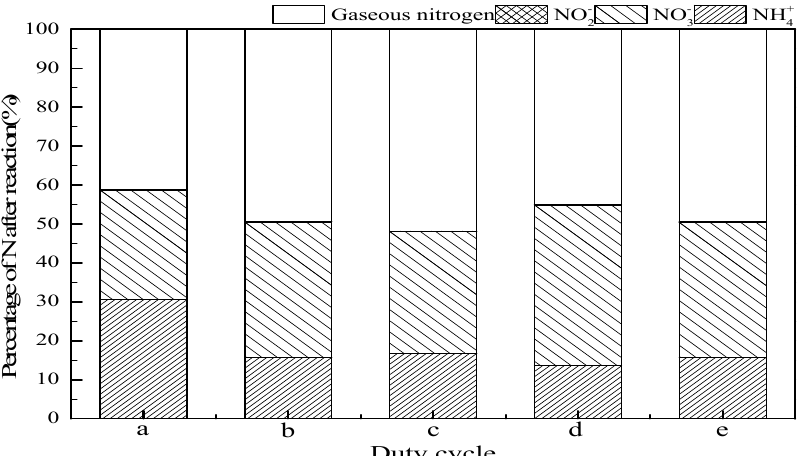
Figure 8. Effect of duty cycle on ammonia conversion. Reaction conditions: initial NH 4+ concentration 50 mg/L, initial pH 9.5, ozone flow 0.8 g/h, catalytic dosage 2.0 g/L, temperature 25 °C, reaction time 60 min, ultrasonic frequency 25 kHz, ultrasonic power 270 W. ( a ) No ultrasound, ( b ) duty cycle 1:2, ( c ) duty cycle 1:3, ( d ) duty cycle 2:3, ( e ) duty cycle 2:4.